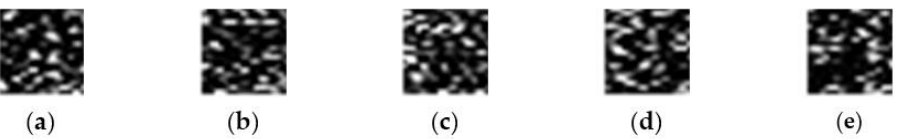
Figure 12. Partial 20 × 20 sample graph without target under the condition of 0 dB SNR, and the units are ( a ) 1000th, ( b ) 2000th, ( c ) 3000th, ( d ) 4500th, and ( e ) 6000th.